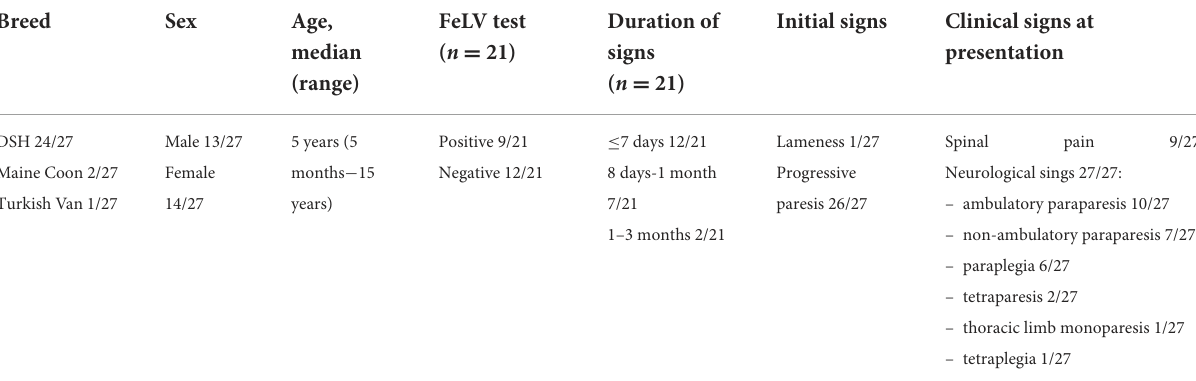
TABLE 1 Signalment and clinical data of 27 cats with spinal lymphoma.